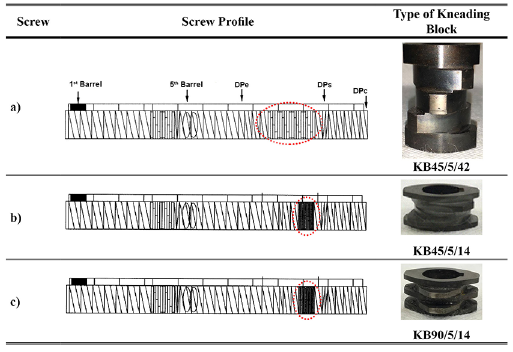
Figure 1. Twin screw profiles with four kneading blocks of five discs positioned in the mixing zone between two pressure transducers (DPe e DPs), where: a) screw 4KB45/5/42, b) screw 4KB45/5/14 and c) screw 4KB90/5/14.